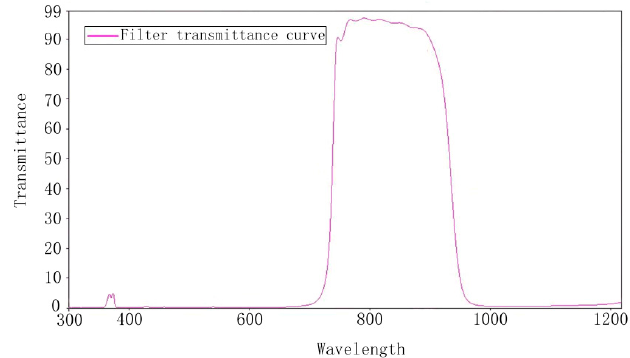
Figure 5. The transmittance curve of the narrow ‐ band filter at the front end of the telescope.